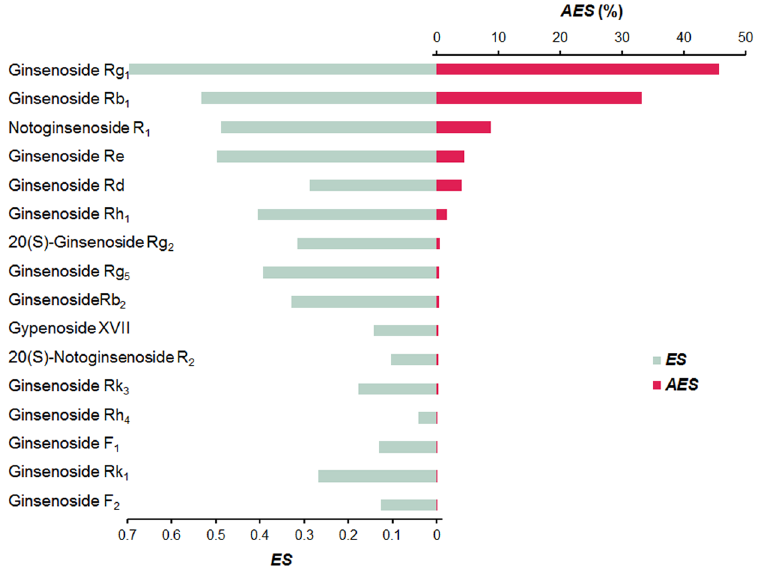
Figure 3. The ES and AES of the constituents in